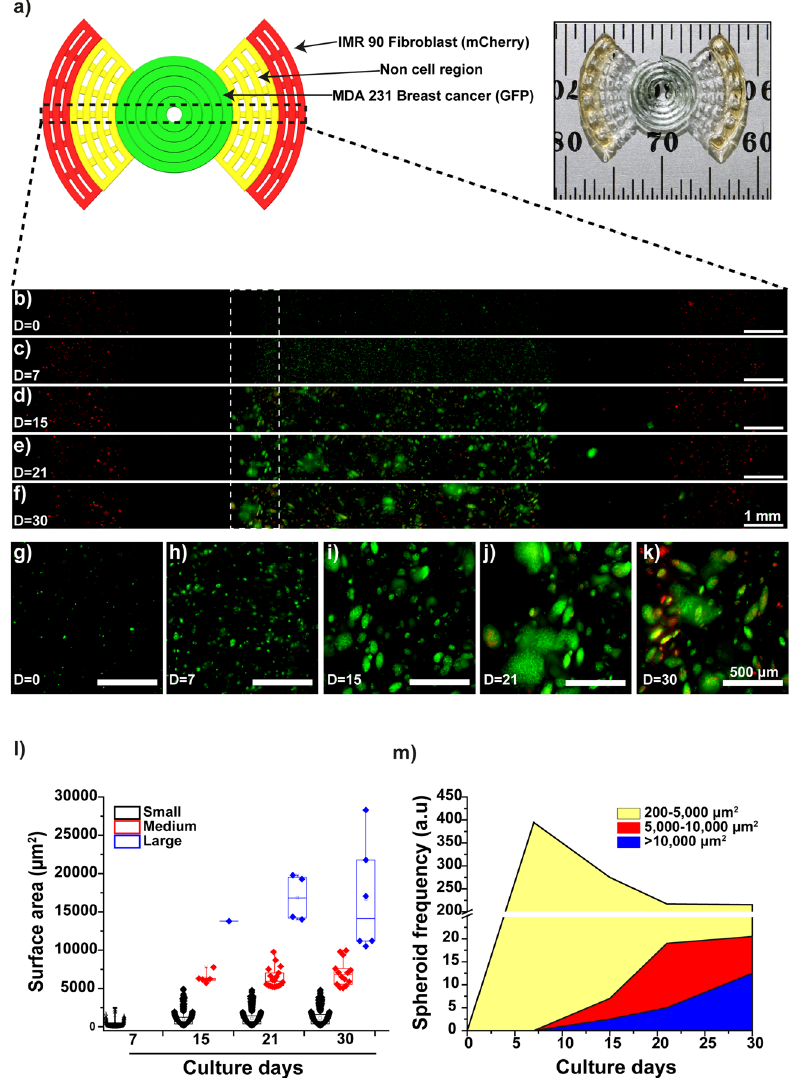
Figure 3. MCTS formation within a 3D bioprinted in vitro model consisting of IMR-90 fibroblasts and MDA-MB-231 triple-negative breast cancer cells. ( a ) CAD model and photograph of the bioprinted in vitro sample. ( b ) Confocal time-lapse image of MDA-MB-231-GFP (green) and IMR-90-mCherry (red) cells bioprinted within the model ( b–f ) and their zoom-in ( g – k ). Scale bar is 1 mm ( b – f ) and 500 µ m for selected areas (dotted line ( g – h )), magnification x10. ( l ) MCTS formation and size quantification during a 30 day period: 500–10,000, 10,000–20,000 and > 20,000 µ m 2 for small, medium and large spheroids, respectively. ( m ) Frequency of MCTS distribution as a function of time cultured. Box plot graphs were plotted using a box limit of 25 th and 75 th percentiles and a minimum-maximum whisker’s